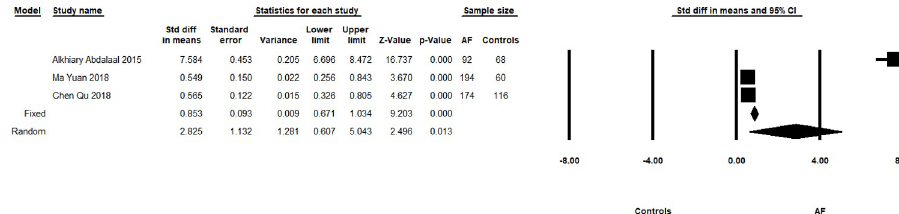
Fig 5. Summary forest plots showing the Meta-SMD and 95% CI of sST2 levels in AF patients and healthy controls. The Meta-HR in the random effects model is shown by the black diamond at the bottom. The vertical line at 1 is the border for